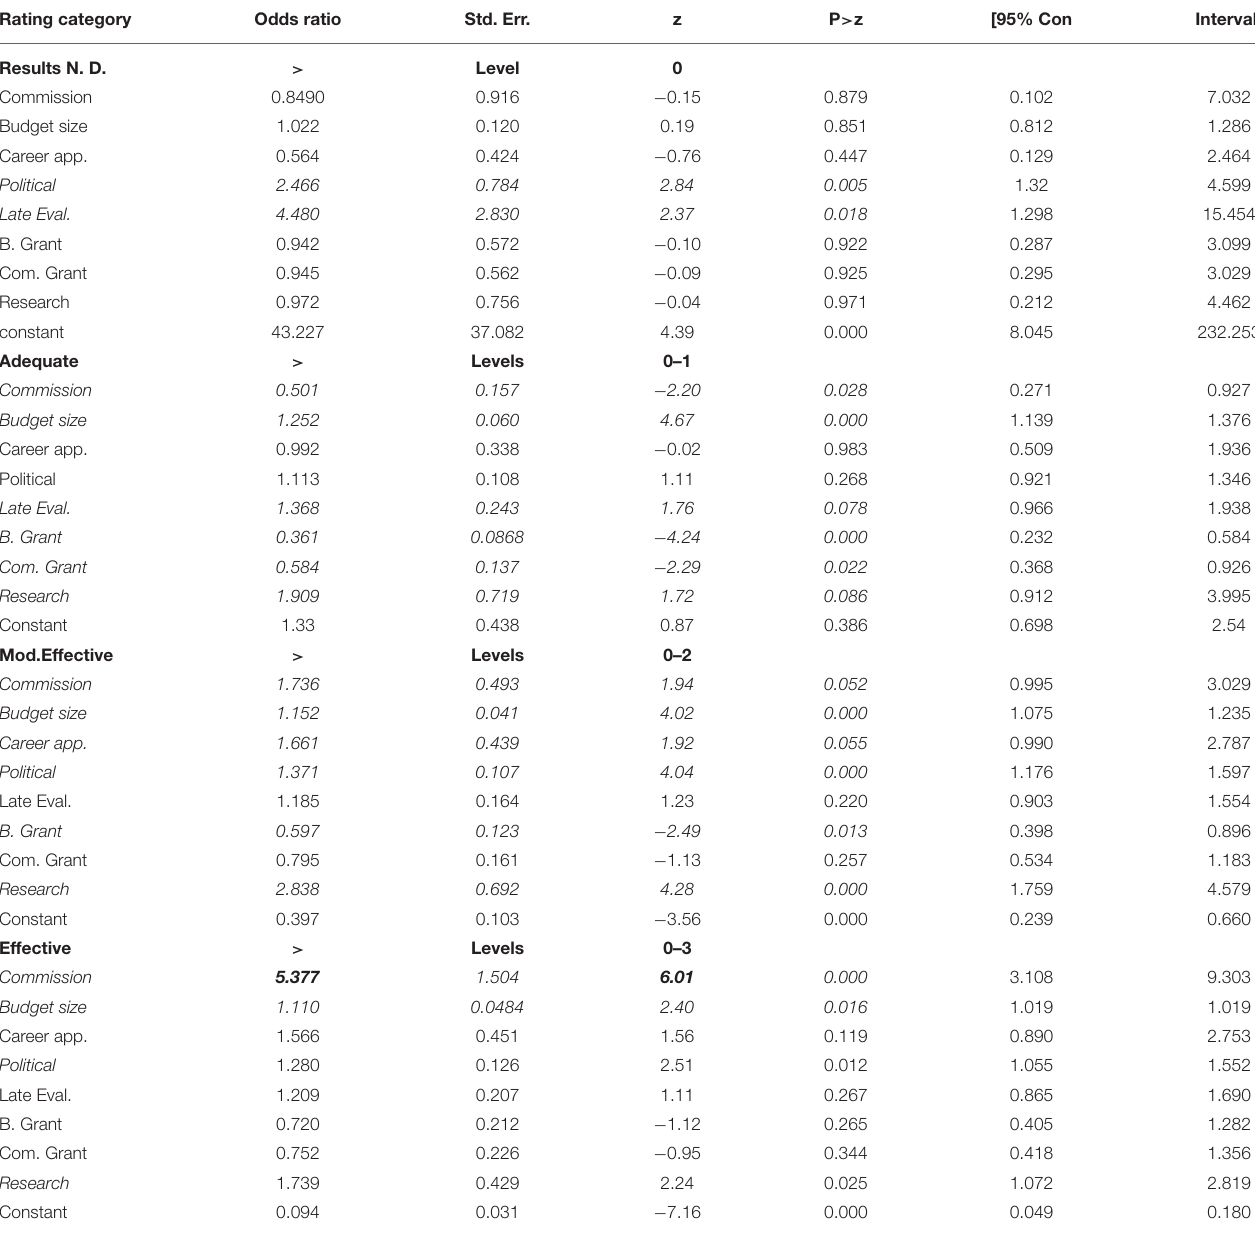
TABLE 9 | Generalized ordered logistic model of PART categories. Rating category Odds ratio Std. Err. z P > z [95% Con